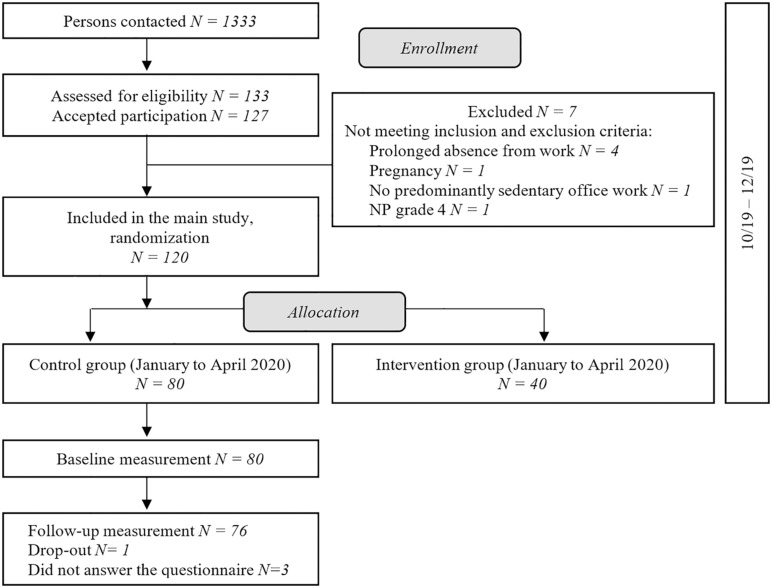
Study flow-chart.